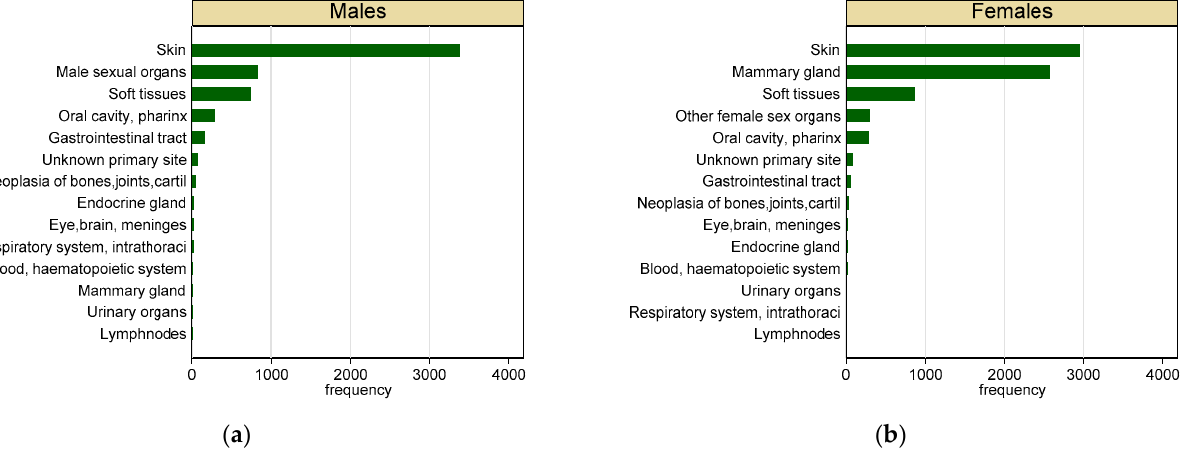
Figure A1. Frequency of benign tumours by sex and topography. ( a ) Males; ( b ) females.